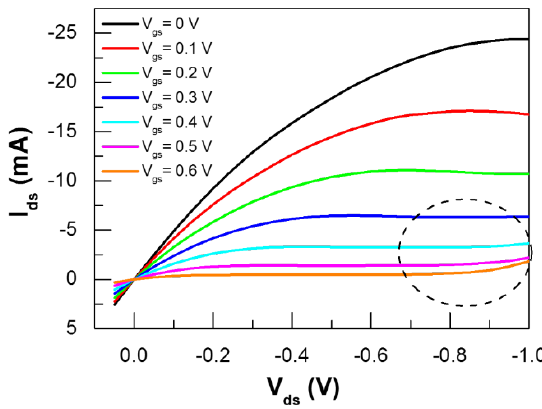
Figure 2. Output characteristics of an OECT with a 70-nm-thick PEDOT:PSS channel recorded by sweeping V ds between 0.05 V and − 1 V at a scan rate of 50 mV/s and a constant gate bias ( V gs ) fixed between 0 and 0.6 V, with V gs steps of 0.1 V. The dotted circle corresponds to the onset of the electrolysis of the aqueous sodium chloride electrolyte.